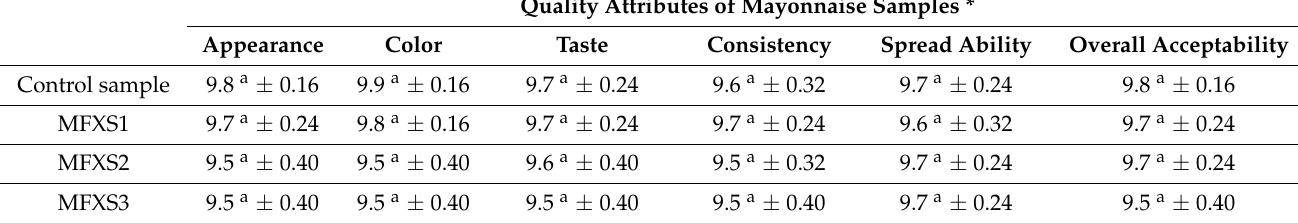
Table 2. Sensory results of mayonnaise samples.